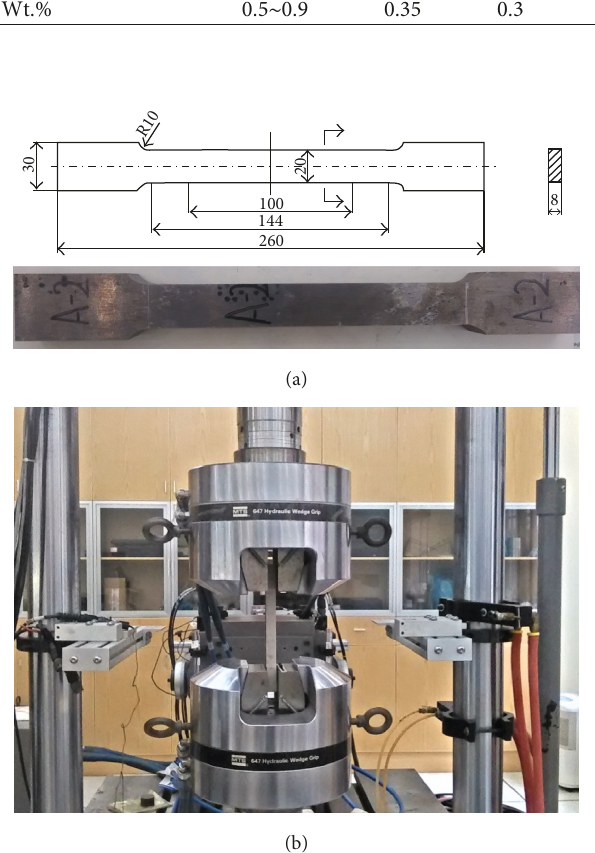
Figure 1: (a) Specimen for the conventional tension test; (b) MTS 647 hydraulic wedge grip used for the conventional tension test.